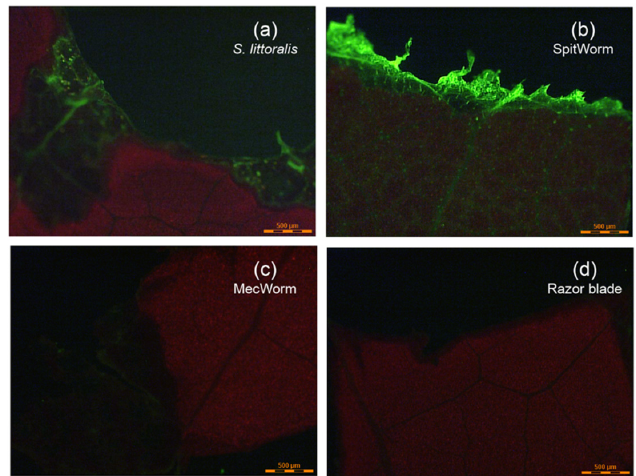
Figure 5. Fluorescent microscopy images of lima bean leaves after different treatments. Detail view of wounding edges of the adaxial leaf surface. Treatments: ( a ) S. littoralis larva injected with Lucifer Yellow solution; ( b ) SpitWorm delivering Lucifer Yellow labeled larval OS; ( c ) MecWorm; and ( d ) cut with a razor blade.